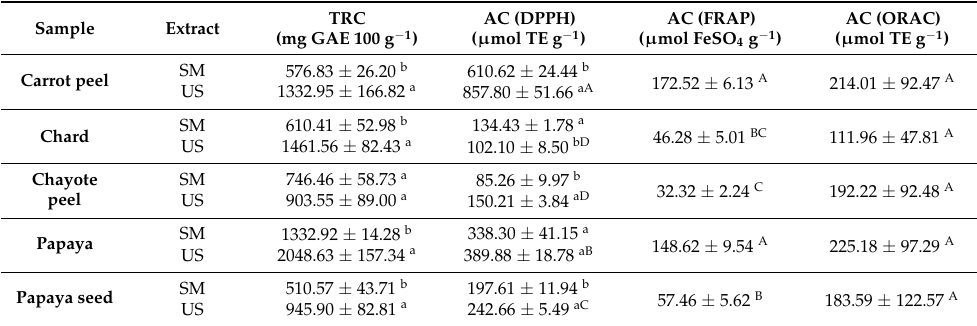
Table 2. Comparison between the selected mixture extract (SM) and ultrasonication extract (US) of five fruit and vegetable by-products (FVB) in terms of total reducing capacity (TRC) and antioxidant capacity (AC) by DPPH method as well as the antioxidant capacity of ultrasonication extracts by FRAP and ORAC